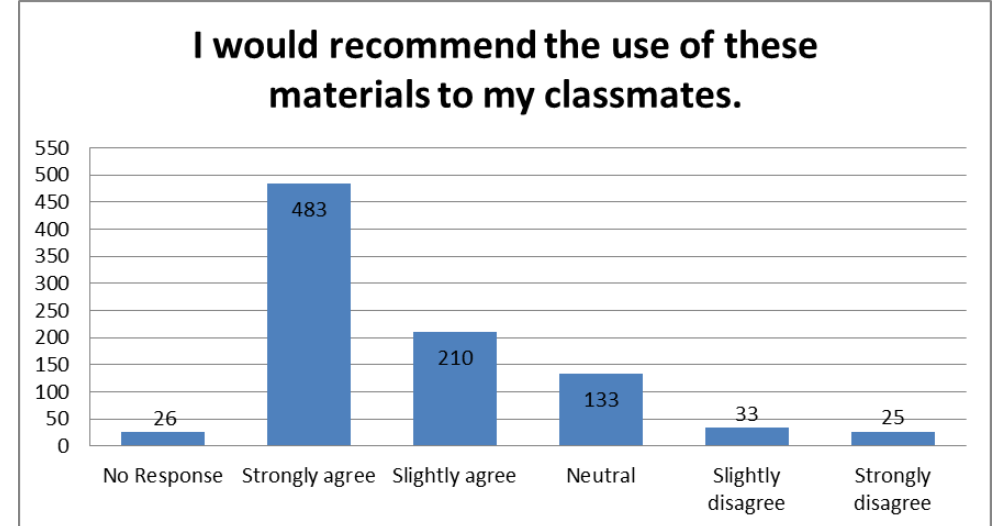
Figure 3 . Student responses to the statement, “I would recommend the use of these materials to my